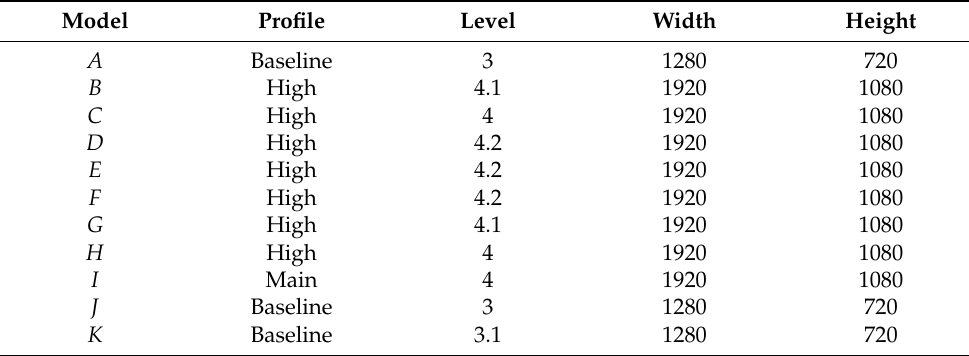
Table 13. Examples of basic parameters in H.264 encoder’s descriptors. Model